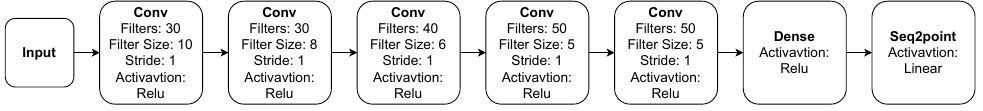
Figure 2. Architecture of S2P.